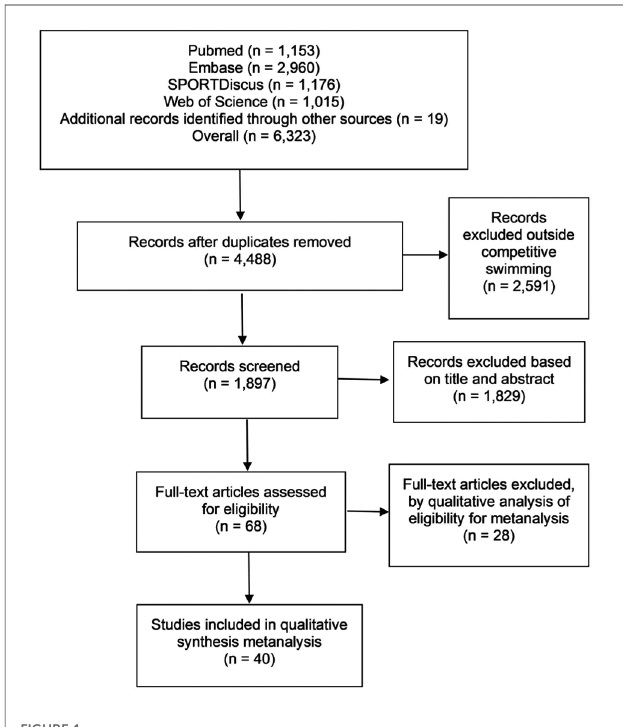
FIGURE 1 Flowchart summary of the studies selection